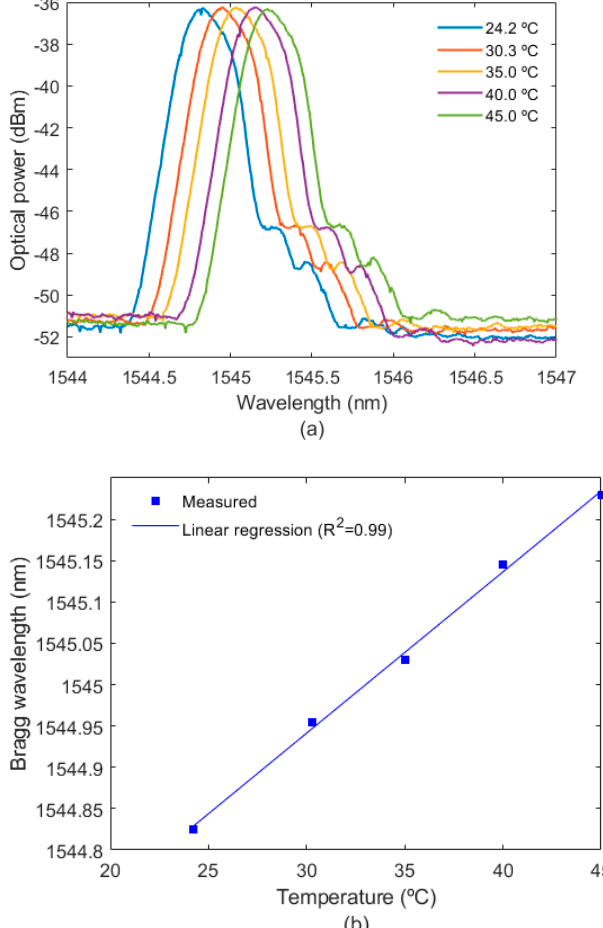
Figure 5. ( a ) FBG spectra as a function of the temperature, ( b ) Bragg wavelength shift for different temperatures.